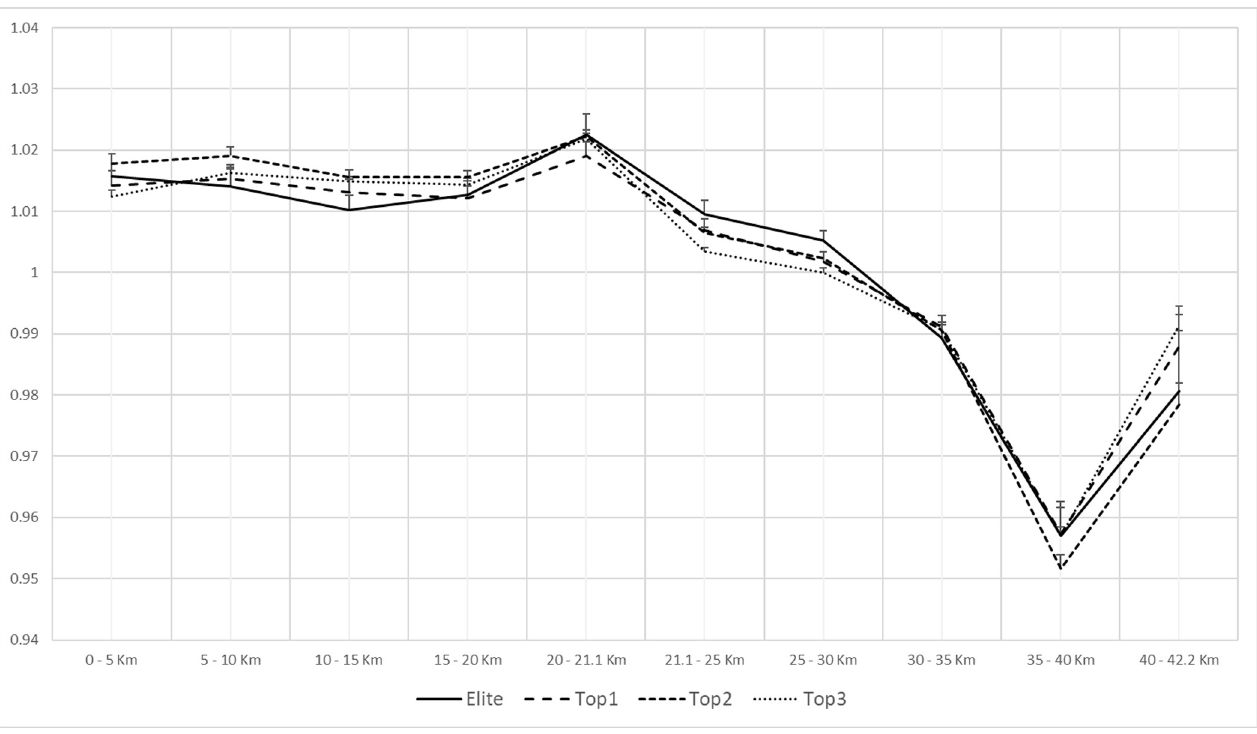
PLOS ONE | https://doi.org/10.1371/journal.pone.0236658 July 28,